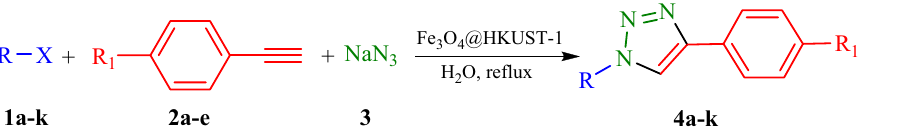
Figure 2. Synthesis of 1,2,3-triazole derivatives in presence of catalyst (Fe 3 O 4